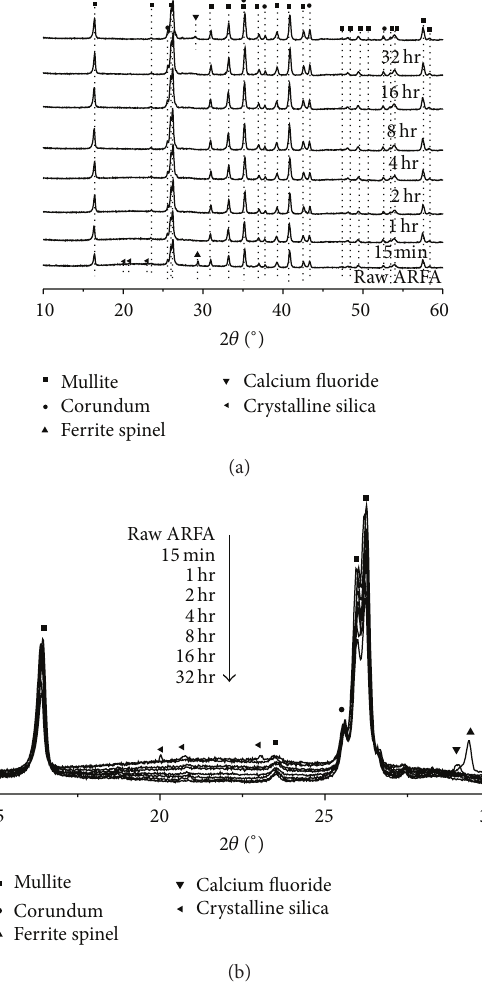
Figure 4: The XRD spectra of ARFA from acid digestion process, (a) in the 2 𝜃 range of 10–60 ∘ and (b) in the enlarged 2 𝜃 range of 15– 30 ∘ . Note that the spectra in (a) have been offset for clarity and the spectra in (b) are given without